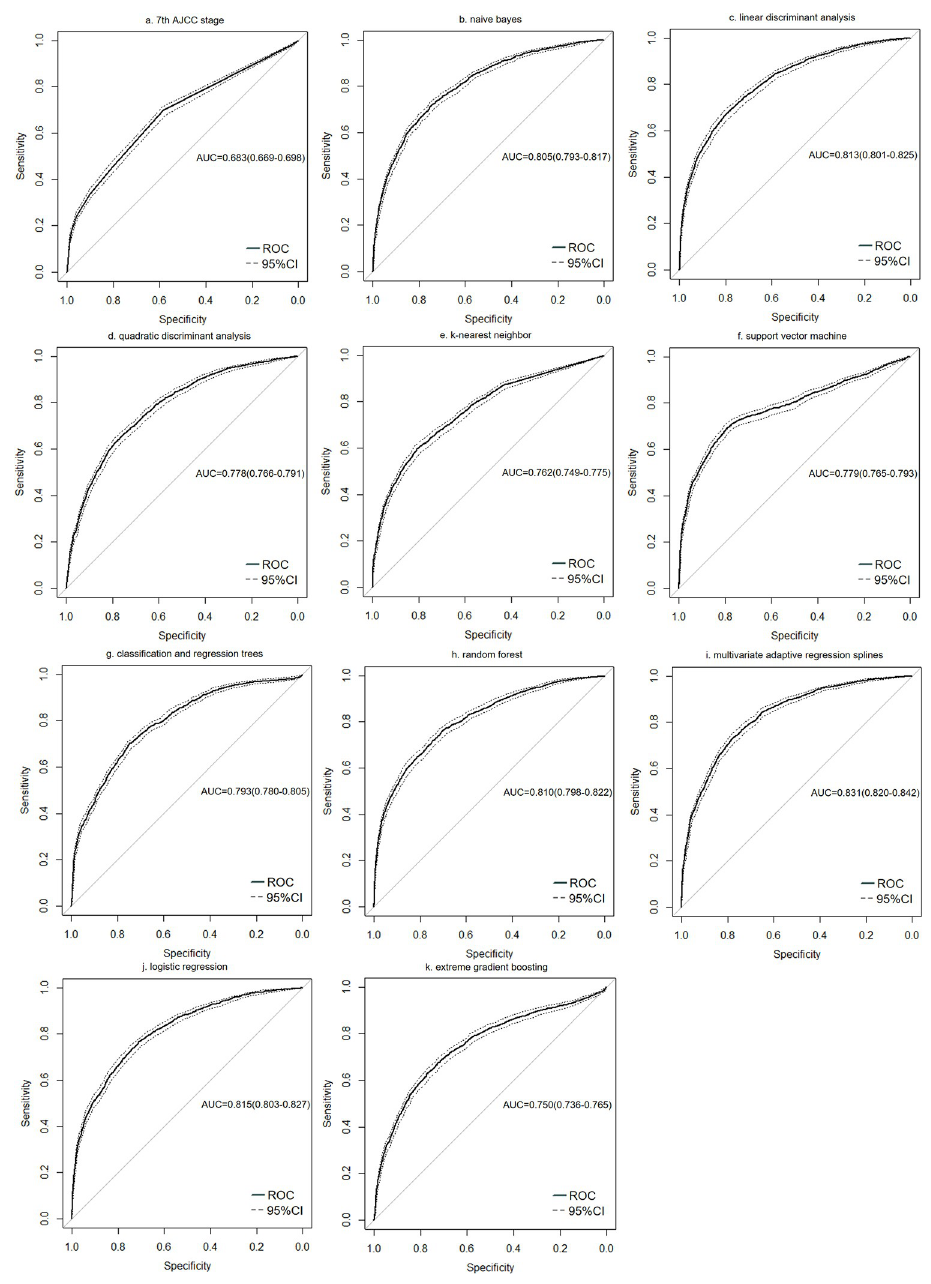
Fig 3. The ROC curves of 10 ML algorithms and 7th AJCC stage on 5-year OS in the test set.